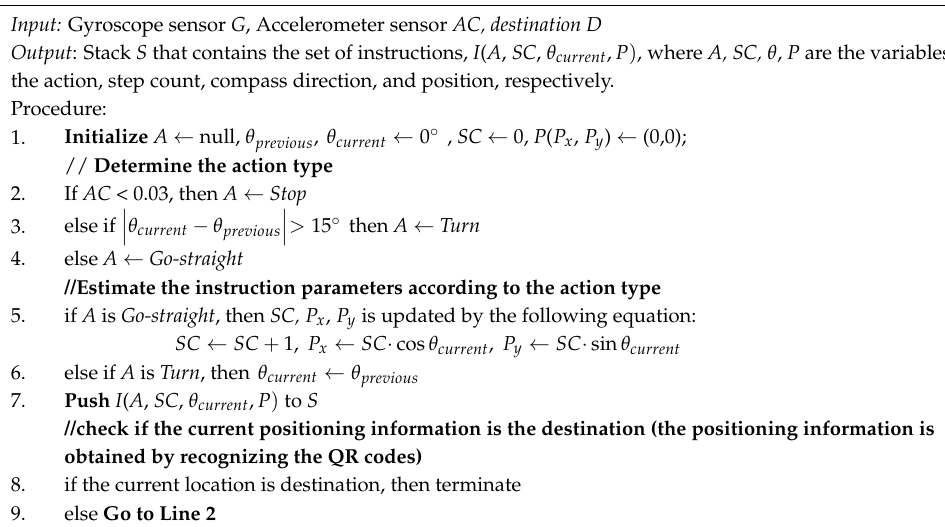
Algorithm 1: The proposed trajectory recording